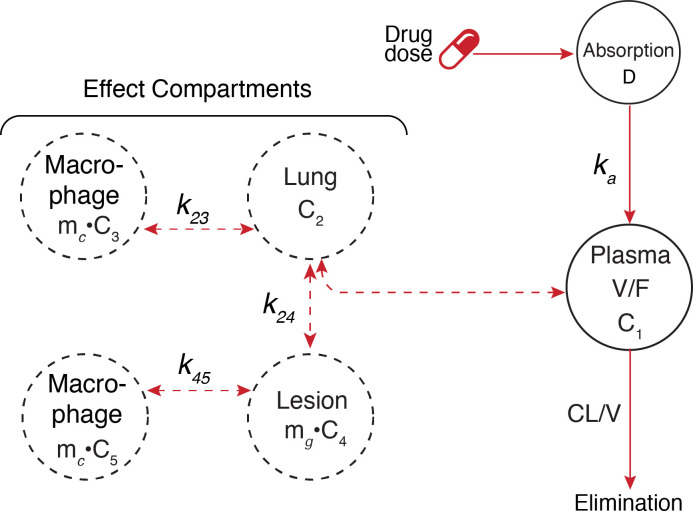
Overview of disease model.Description of key aspects of the disease model. Bacterial infection occurs by aerosolized bacteria reaching the lungs. The bacteria remain in lung tissue, and may be absorbed into macrophages. With long-standing disease granulomatous lesions may form, which in-part may work to contain the bacteria, but also may limit effectiveness of drug therapy and thus form a partial reservoir of bacteria. Bacterial growth, killing, mutation, and drug effects are present for each model compartment. Dotted lines represent movement of immune cells and solid lines represent movement of bacteria.